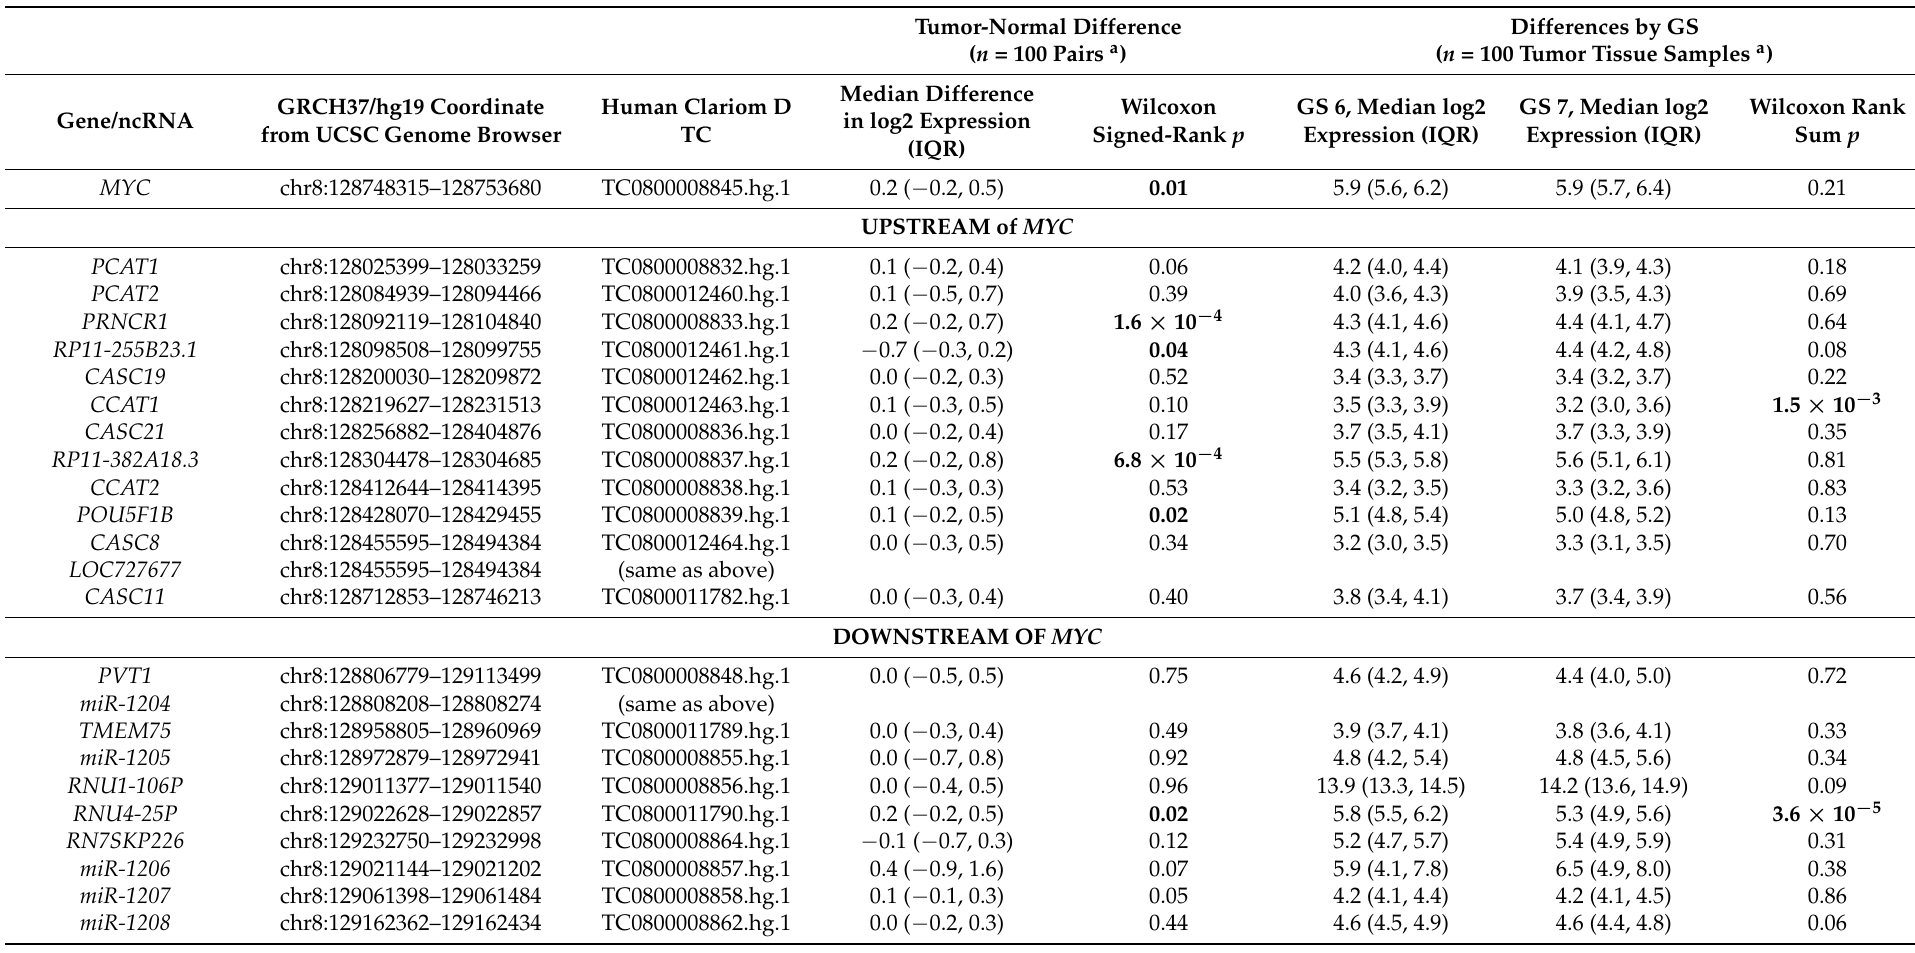
Table 4. List of genes and ncRNAs within 1 Mb of MYC and their locations, associated transcript cluster IDs in the Human Clariom D array data and RNA expression differences between paired tumor and normal prostate tissue samples and between GS 6 and GS 7 prostate tumor samples from the University of Maryland.